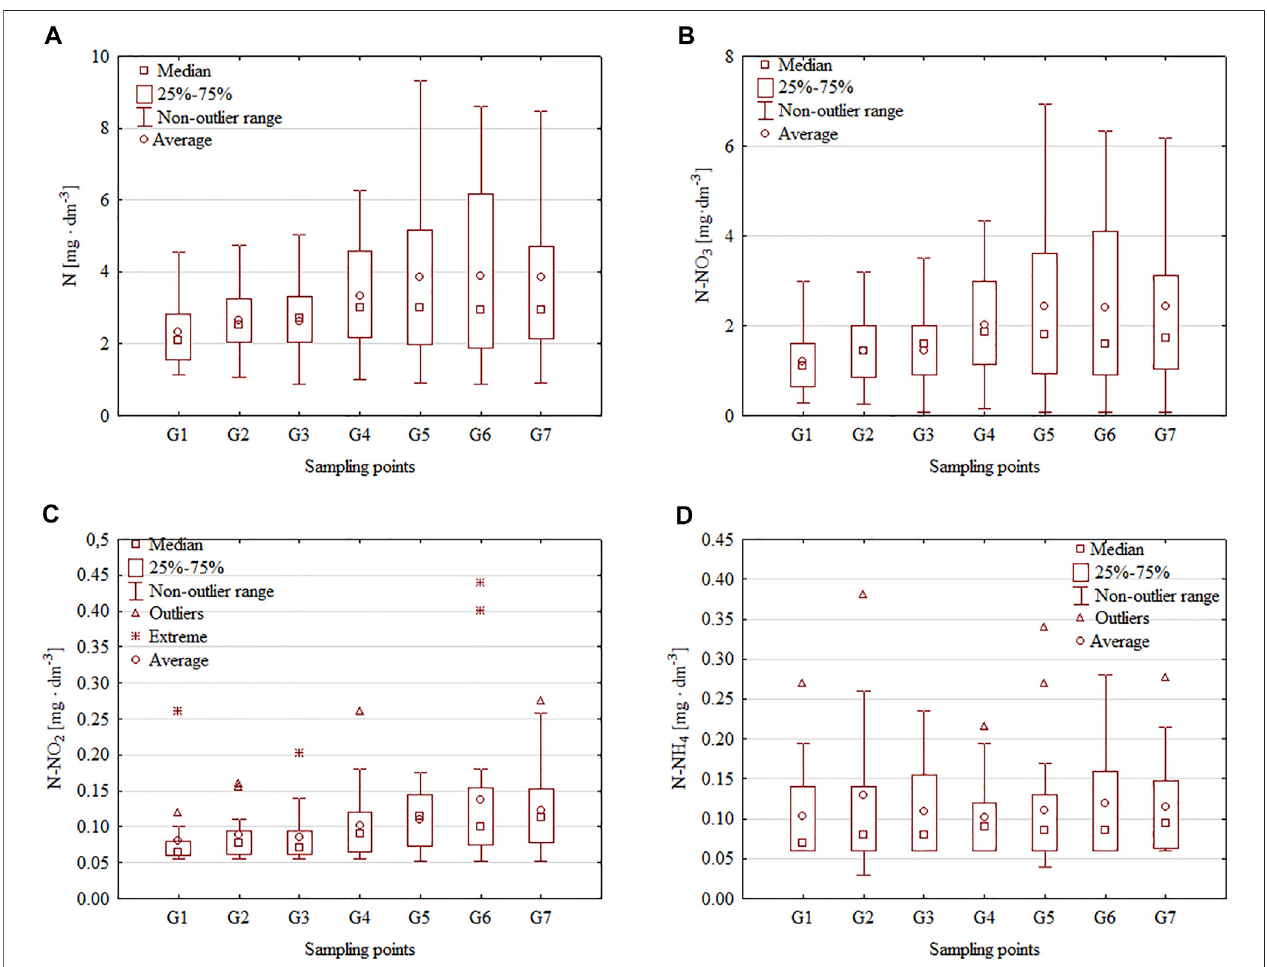
FIGURE 3 | Spatial variability of: (A) total nitrogen; (B) nitrite nitrogen; (C) nitrate nitrogen; (D) ammonium nitrogen in the waters of the G ł uszynka river in the hydrological years 2016 – 2018.